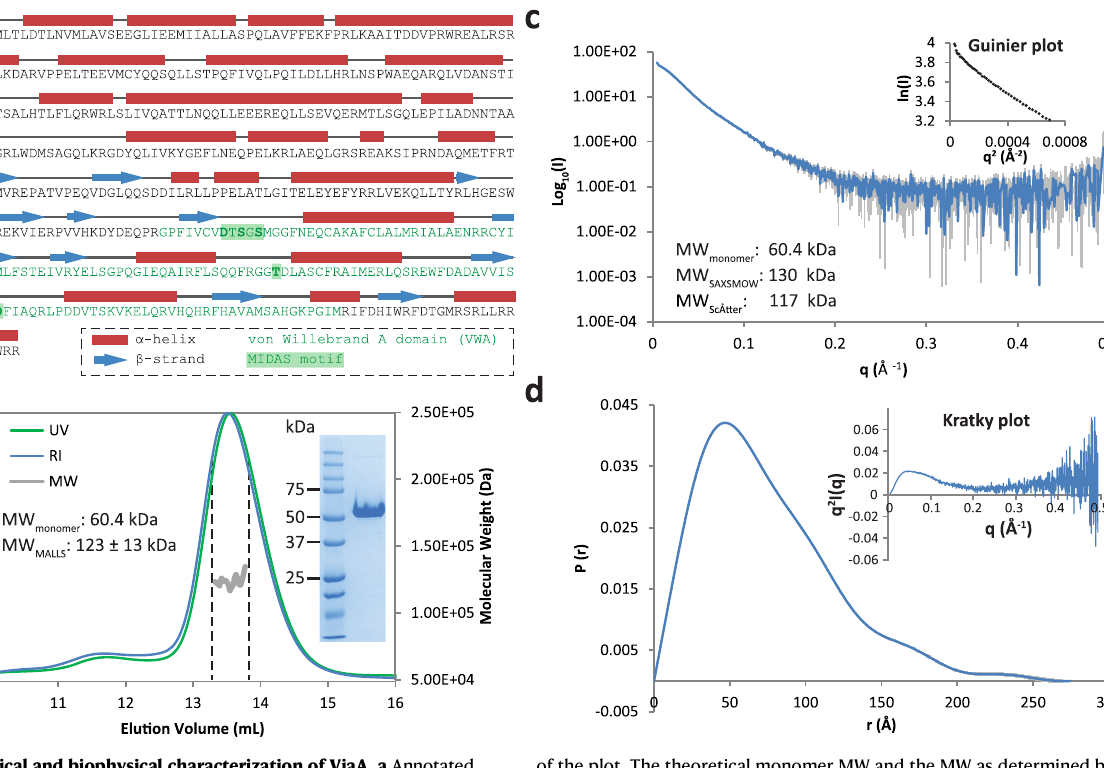
of the plot. The theoretical monomer MW and the MW as determined by MALLS are annotated on the left-hand side of the plot. The MALLS experiment was performed once. c SAXS curve of puri fi ed AviTag-ViaA-His. An inset shows a Guinier Plot zooming in on the low-q region of the scattering curve. The theo- reticalmonomerMWaswellastheMWdeterminedbySAXSMOWandScÅtterare shown on the left. d Pair-wise distance distribution function P(r) and Kratky plot (top right inset) of the AviTag-ViaA-His SAXS data. Source data are provided as a Source Data fi